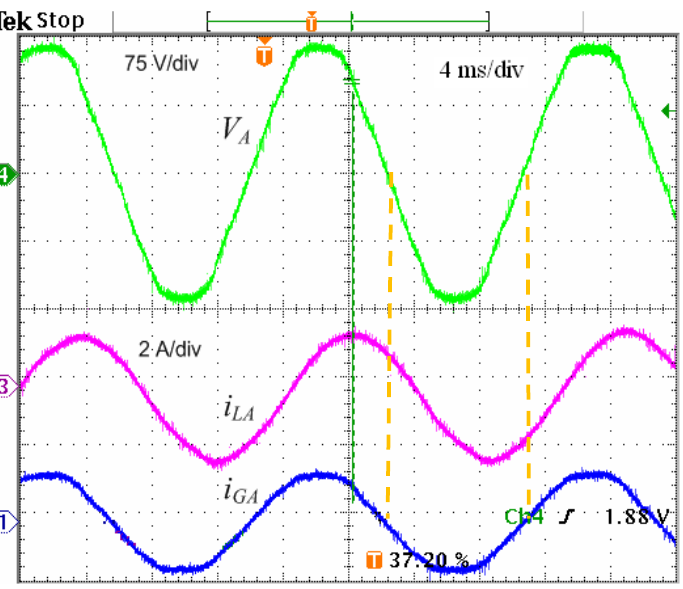
Figure 19. Grid phase voltage ( V A ), load current ( i LA ), and grid phase current ( i GA ) for Phase